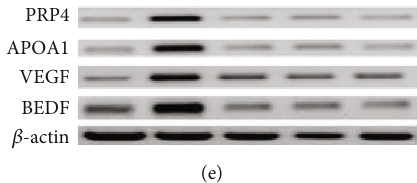
Figure 3: The changes of BDEF, VEGF, ABOA1, and PRP4 protein expression in di ff erent groups. The e ff ect of melatonin and/or stem cell on diabetic rats on the expression levels of BDEF (a), VEGF (b), ABOA1 (c), and PRP4 (d) and (e) images of western blotting bands of the measured protein expression in di ff erent groups. Data are presented as mean ± SE ( n = 10 ). a indicates a signi fi cant di ff erence compared to the control group, and b indicates a signi fi cant change compared to the diabetic group at P < 0 : 05 using ANOVA followed by Tukey – Kramer as the post-ANOVA